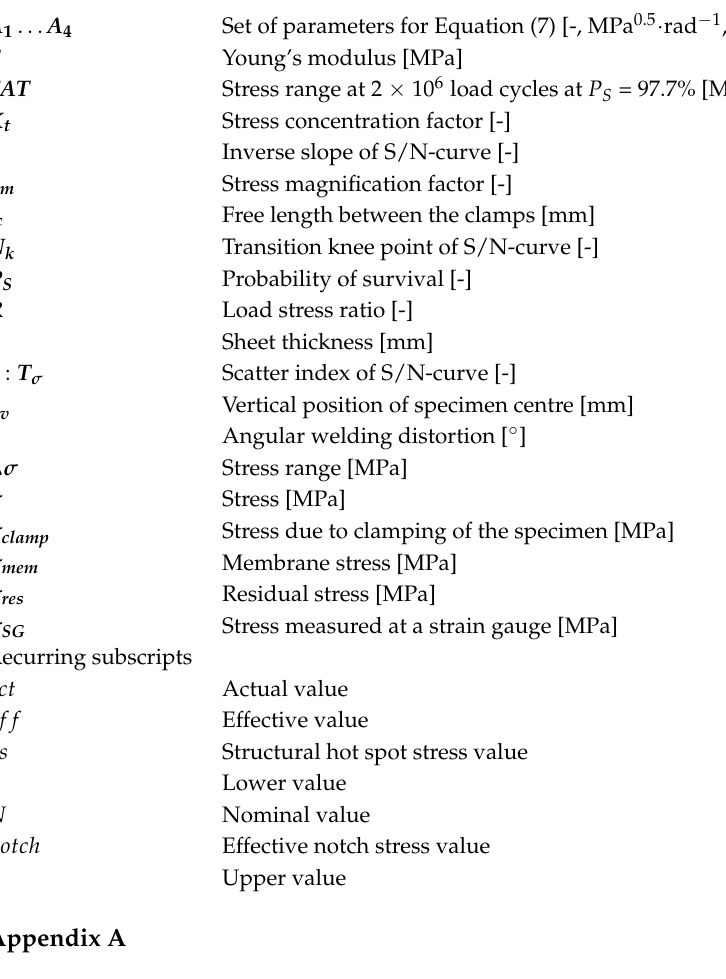
Table A1. Fatigue test and evaluation data of as-welded